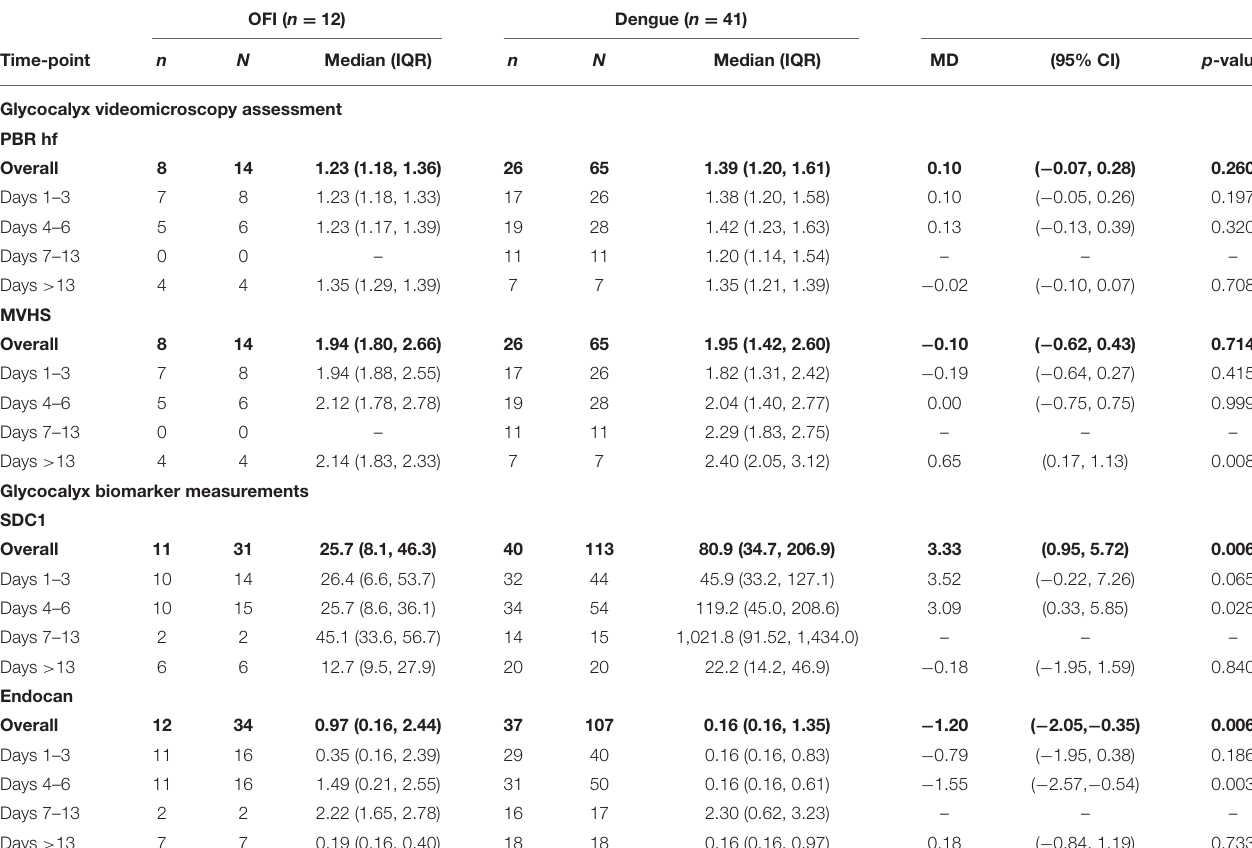
TABLE 2 | Glycocalyx parameters for outpatients with dengue and OFI by disease phase. OFI ( n = 12) Dengue ( n = 41)